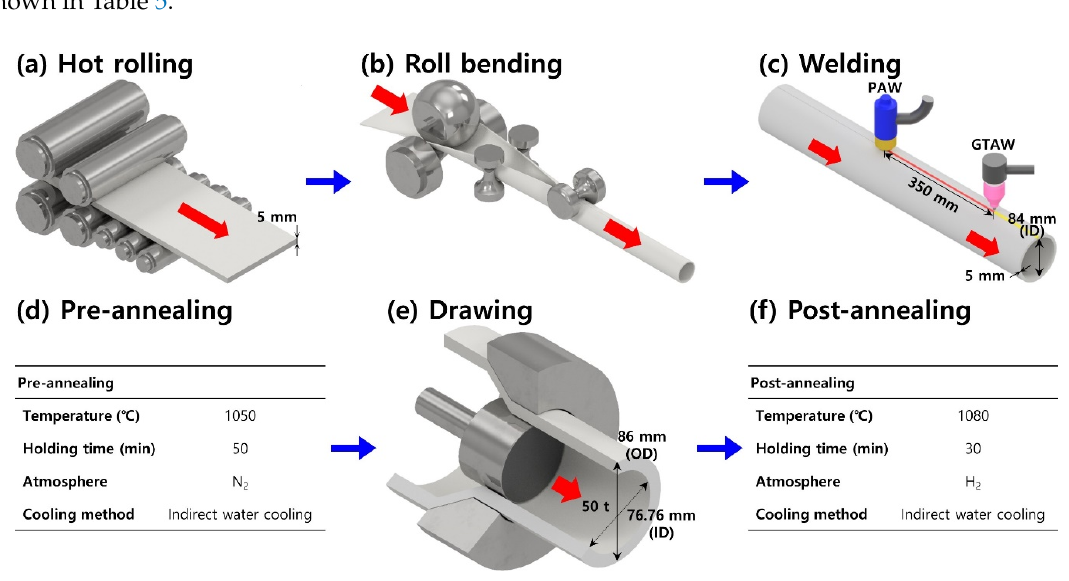
Figure 1. Schematic diagrams of the pipe manufacturing process. Table 1. Chemical composition of the present high-Mn steel sheet.